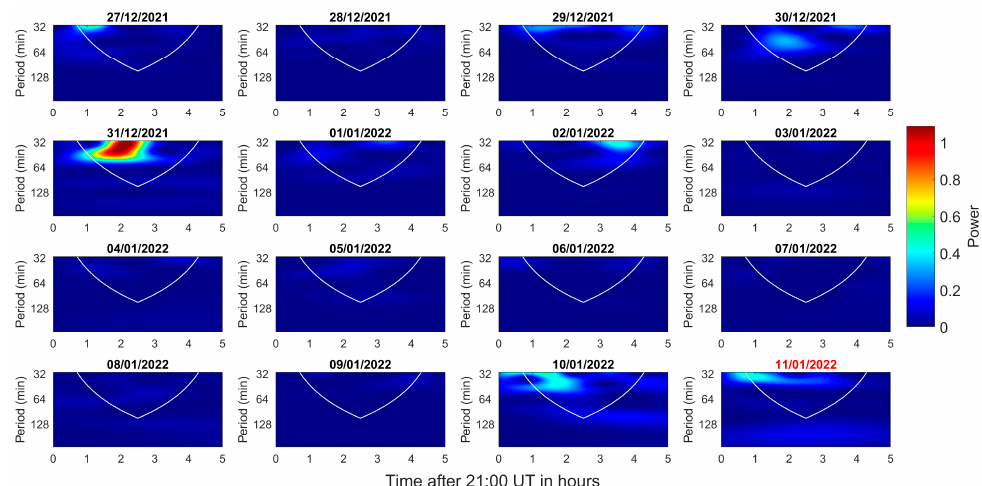
Figure 8. Wavelet power spectrum (WPS) of UWA station. Horizontal axis refers to time of the night after 21:00 UT. The white parabolic line is the cone of influence (CoI). Vertical axis refers to periodicity in minutes and color corresponds to the normalized power (magnitude of periodic structure). The date (11 January 2022) of the EQ is marked with red color at the top of the last panel. Table 10. Results of wavelet analysis for the 2022 Cyprus EQ.